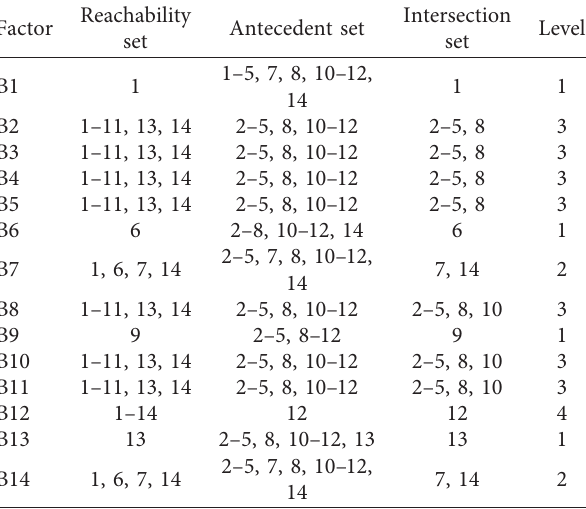
Table 7: Level partitioning